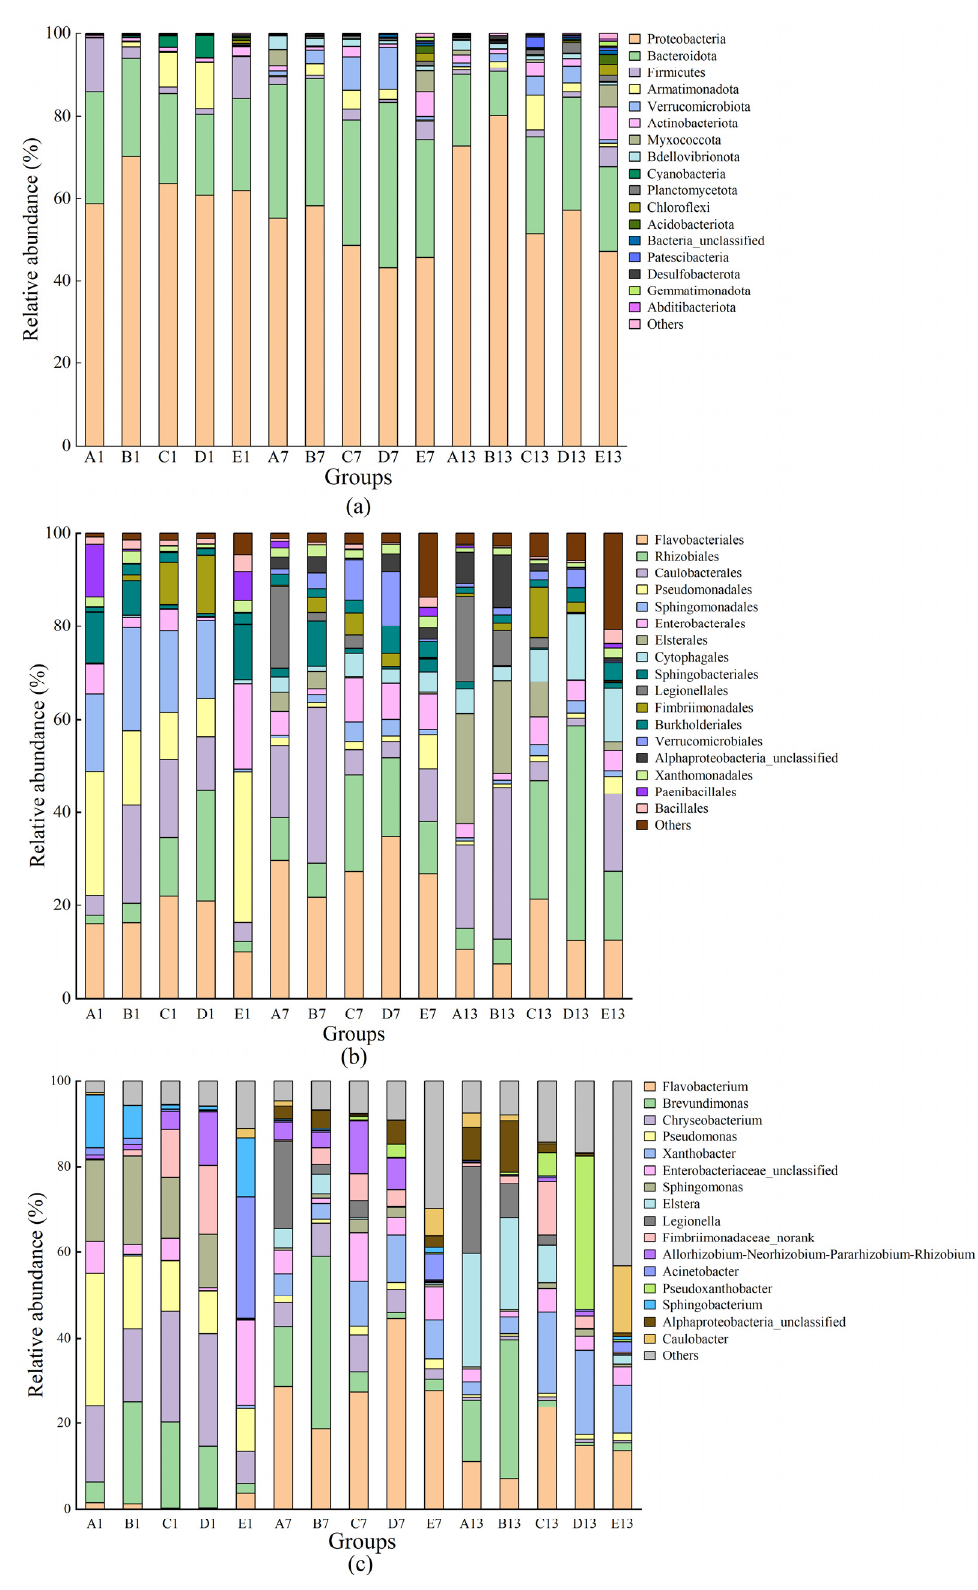
Figure 3. Bacterial community at ( a ) phylum, ( b ) order and ( c ) genus levels of five treatments.